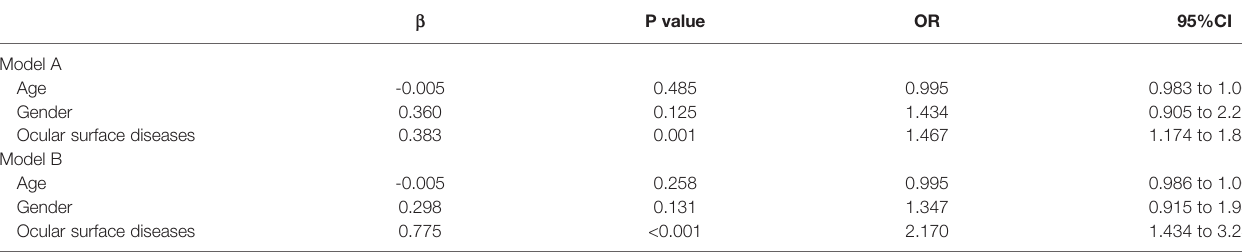
TABLE 4 | Associations between ocular surface diseases and risk of SARS-CoV-2 infection (IgG + or IgM + ). b P value